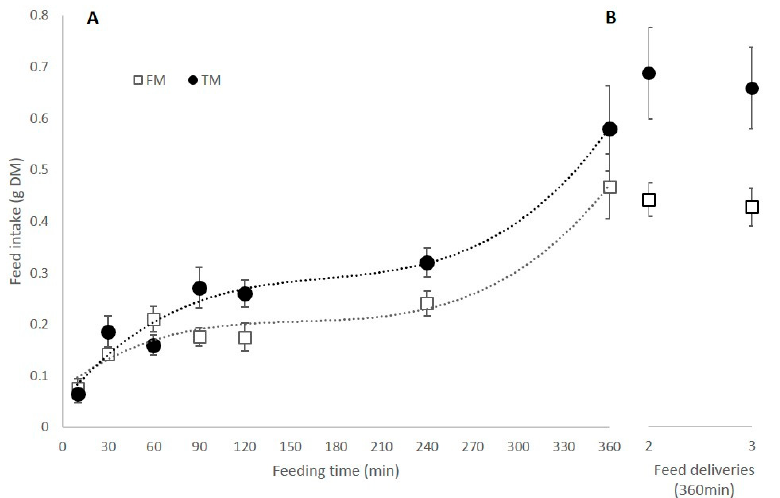
Figure 1. ( A ) Mean feed intake of individual shrimp on a single feed delivery over various feeding durations; ( B ) Mean feed intake over a 360 min feeding duration when fed twice (at time 0 and 180 min) and three times (0, 120 and 240 min). FM: traditional fishmeal-based formulation; TM: terrestrial meal-based formulation.